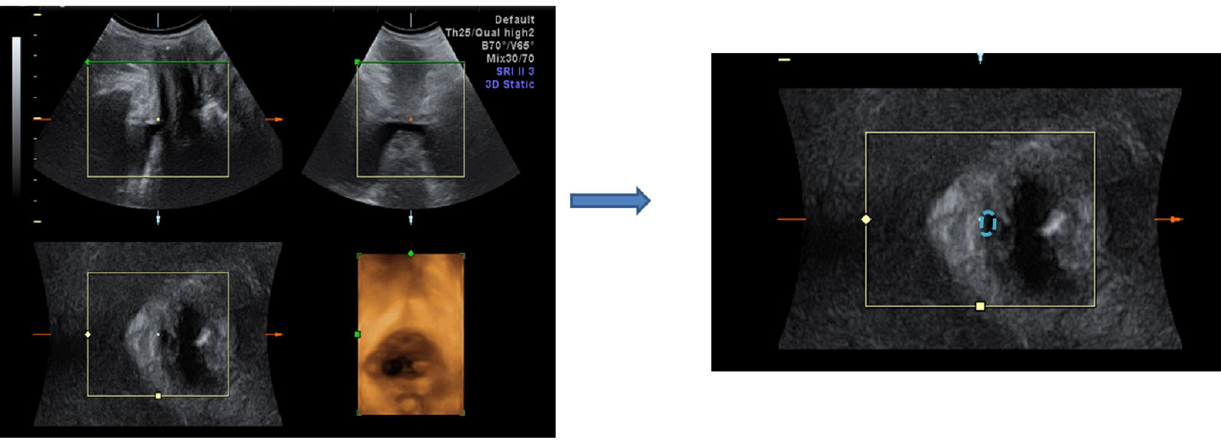
Figure 2. The urethral area is the hypoechoic area marked in a blue dotted line. Data were represented as mean ± standard deviations, and a p < 0.05 indicates a sta ‐ tistically significant difference. Statistical analyses were performed using IBM SPSS Sta ‐ tistical Software version 20.0 ed. Paired t ‐ tests were performed for two related units on a continuous outcome. A p ‐ value of less than 0.05 indicates statistical significance. 3. Results A total of 25 women were included in the study. SUI patient characteristics are shown in Table 1. The mean average age of patients was 42.9 ± 5.6 years, and one patient was men ‐ opausal. The pad test was performed before and 6 months after three sessions of monthly treatments using vaginal Pixel CO 2 Laser. The ICIQ scores of all subjects were classified into mild ( n = 12; 48%), moderate ( n = 9; 36%), severe ( n = 2; 8%), and very severe ( n = 2; 8%). In the pad test, urine leakage decreased significantly, and the ICIQ data showed that 80% (20/25) reported improvement in SUI symptoms ( p = 0.023) (Table 1). Two women with very severe SUI experienced no beneficial effect after laser intervention, and the remaining three women suffered from mild, moderate, and severe SUI before treatment. Table 1. Clinical background of the participants. Data are given as mean ± standard deviation or n (%). Pre ‐ Operation (n = 25)